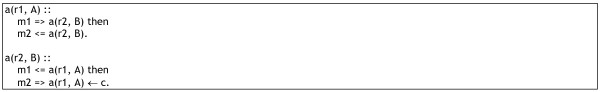
A basic interaction model in LCC.